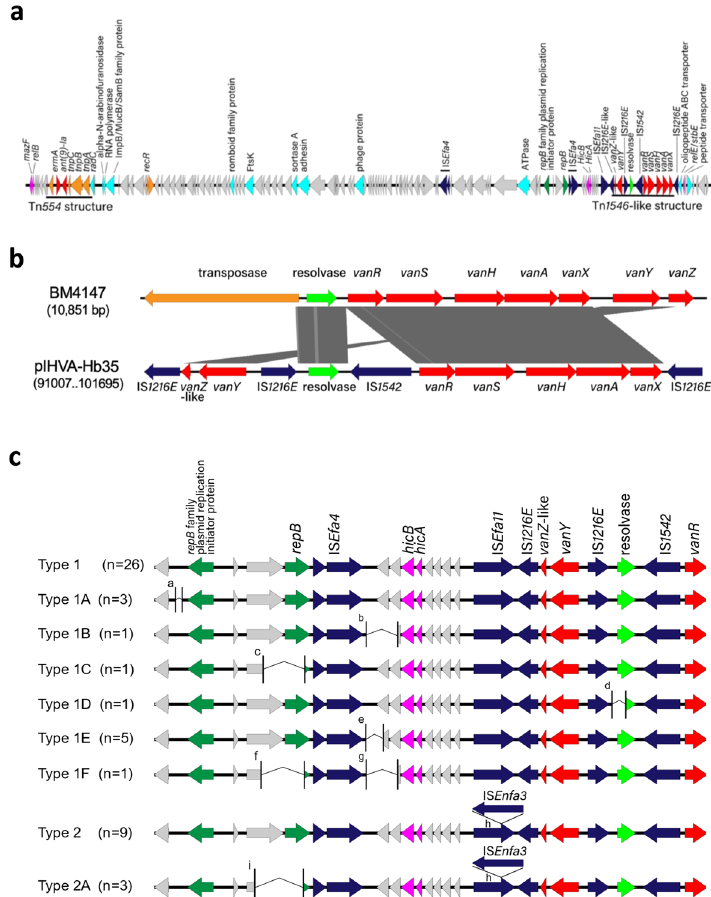
Figure 6. Genomic analysis of a linear plasmid carrying vanA (pIHVA). ( a ) Genomic structure of pIHVA from the Hb35 strain. Block arrows indicate confirmed or putative open reading frames (ORFs) and their orientations. Arrow size is proportional to the predicted ORF length. Color code is as follows: red, antimicrobial resistance genes; orange, transposase genes; green, plasmid replication initiator genes; light green, resolvase genes; cyan, genes encoding proteins of known function; deep blue, insertion sequence; and magenta, plasmid stabilization system. Putative, hypothetical, and unknown genes are represented by gray arrows. ( b ) Comparison of Tn 1546 -like region of pIHVA-Hb35 with its prototypical structure from BM4147. ( c ) Types of pIHVA found among 50 representative VRE isolates. a Region deletion of 123 bp. b Region deletion of 971 bp. c Region deletion of 1400 bp. d Region deletion of 1416 bp. e Region deletion of 292 bp. f Region deletion of 1380 bp. g